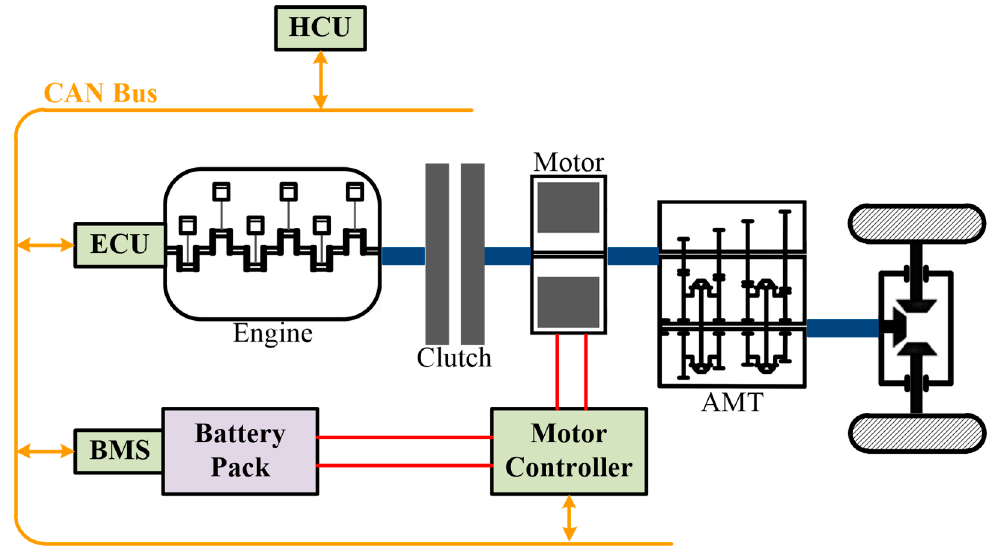
Figure 1. Configuration of the studied hybrid powertrain.